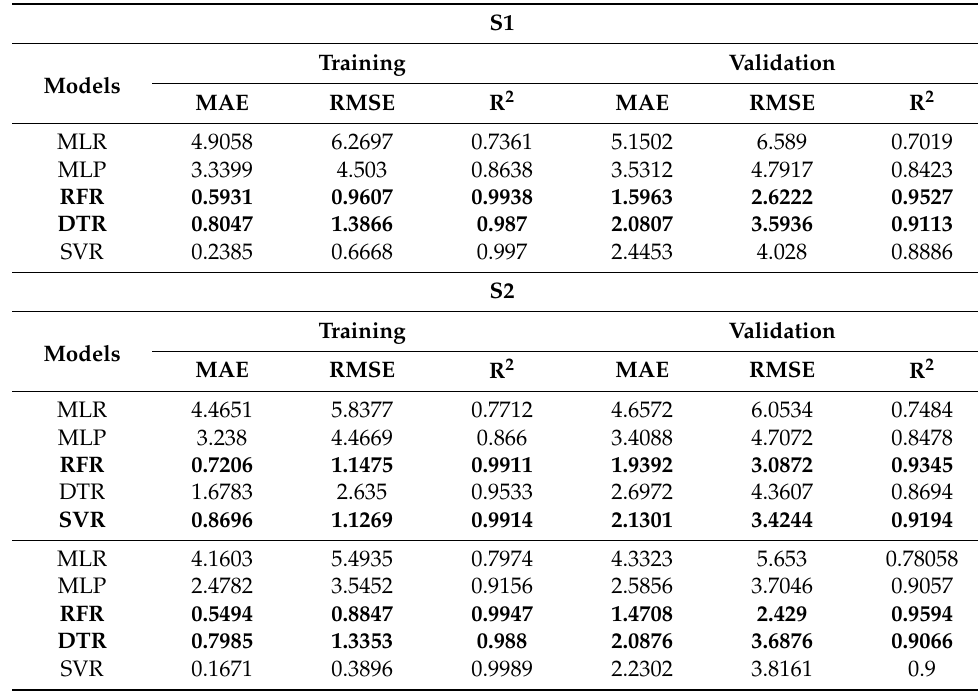
Table 5. The performance assessment of all the models along with S1, S2, and S3 input data set during IRH